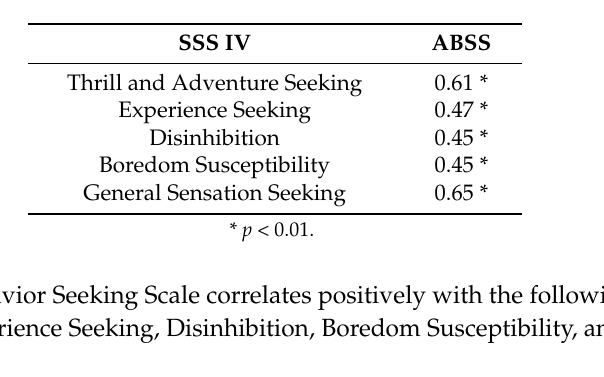
Table 5. The Adventure Behavior Seeking Scale and the Sensation Seeking Scale